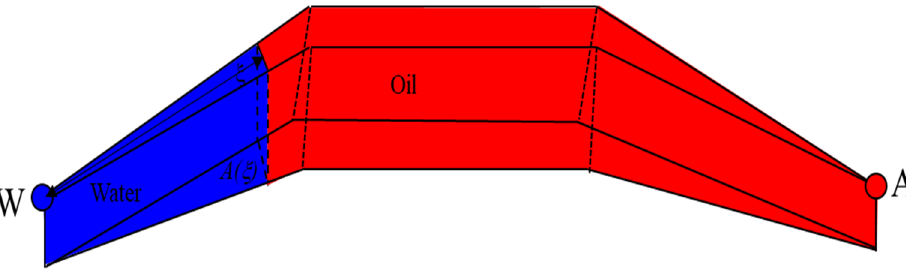
Figure 2. Stream tube model .